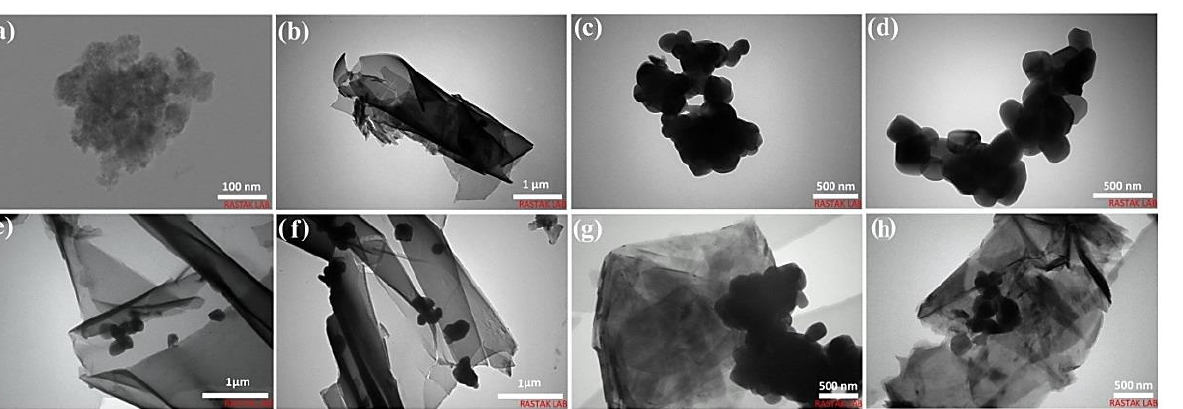
Figure 5. ( a ) XRD pattern and ( b ) Contact angle of MZ, MZ/GO, MZ/1GO-Cu and MZ/2GO-Cu composites after SPS process. 3.2. Mechanical Properties In clinical applications, a biomedical material’s mechanical properties are very im- portant. As a result of the limited specimen size, the hardness and compressive strength were only evaluated. The microhardness of MZ matrix was increased by adding Cu and GO nanosheets (Figure 6a). The hardness of MZ, MZ/GO, MZ/1GO-Cu, and MZ/2GO-Cu was 64 ± 2.1 HV, 75 ± 3.7 HV, 86 ± 3.9 HV, and 91 ± 4.7 HV, respectively. The MZ/2GO-Cu composite has the highest hardness, which is significantly higher than that of MZ. Overall, adding GO to the Mg-based matrix enhanced mechanical properties through synergetic strengthening mechanisms such as grain refinement (GR) and load transfer (LT) strength- ening as well as geometric mismatch (GM) between Mg particles and GO fillers [30]. By providing a pinning effect on the grain boundaries of the Mg matrix, the addition of Cu